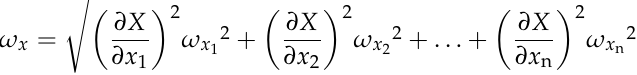
Table 3. Accuracy of the measuring devices.